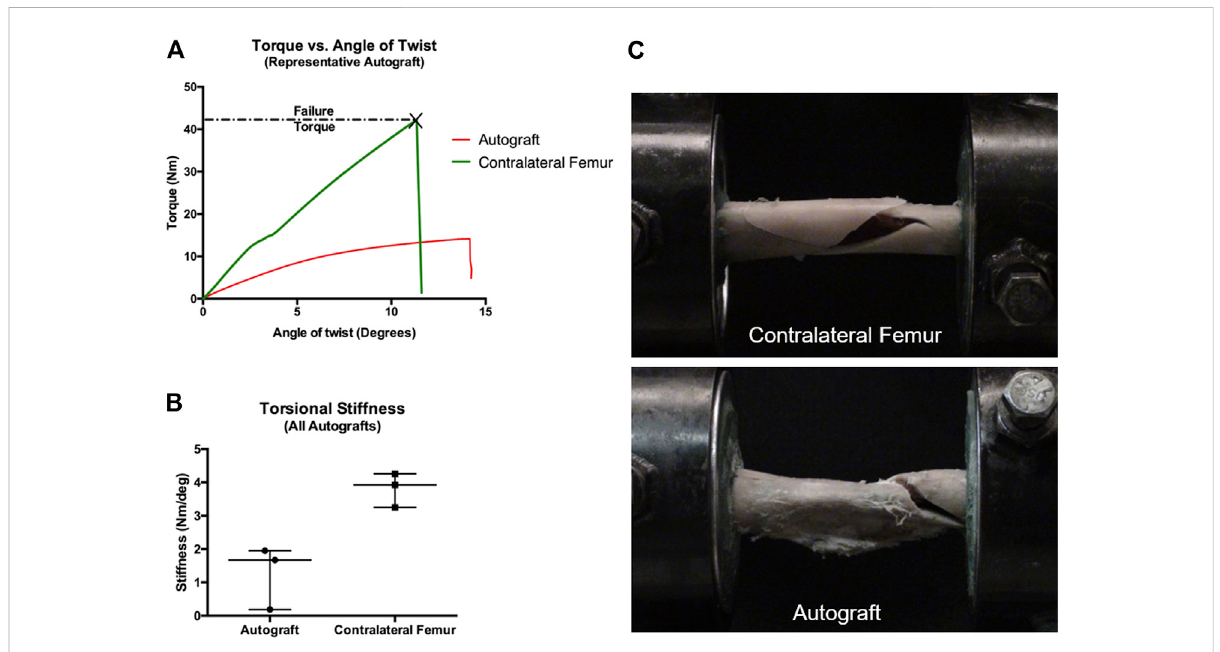
FIGURE 5 Mechanical testing of paired femurs (operated and contralateral non-operated) from autograft treatment group. For femurs containing an AS- ILN, the implant was identi fi ed within the proximal femur and a custom alignment device was used to identify the long axis of the AS-ILN and to position the AS-ILN in the center of the torsional testing axis. Prior to potting, locking bolts were removed. Specimens were potted such that the distance between innermost points of the potting was identical for all specimens. (A) Representative load-deformation (torque-angle of twist) graph for an autograft femur (red) and contralateral, non-operated femur (green). (B) Torsional stiffness values (Nm/ 0 ) were determined from the load-deformation curves from 0 to 5 and reported as scatter plots denoting median and range. (C) Representative mode of failure images. Contralateral, non-operated femurs failed by spiral fracture with comminution. Critical-sized defect femurs treated with autograft failed by spiral fracture through the callus at the junction with the distal